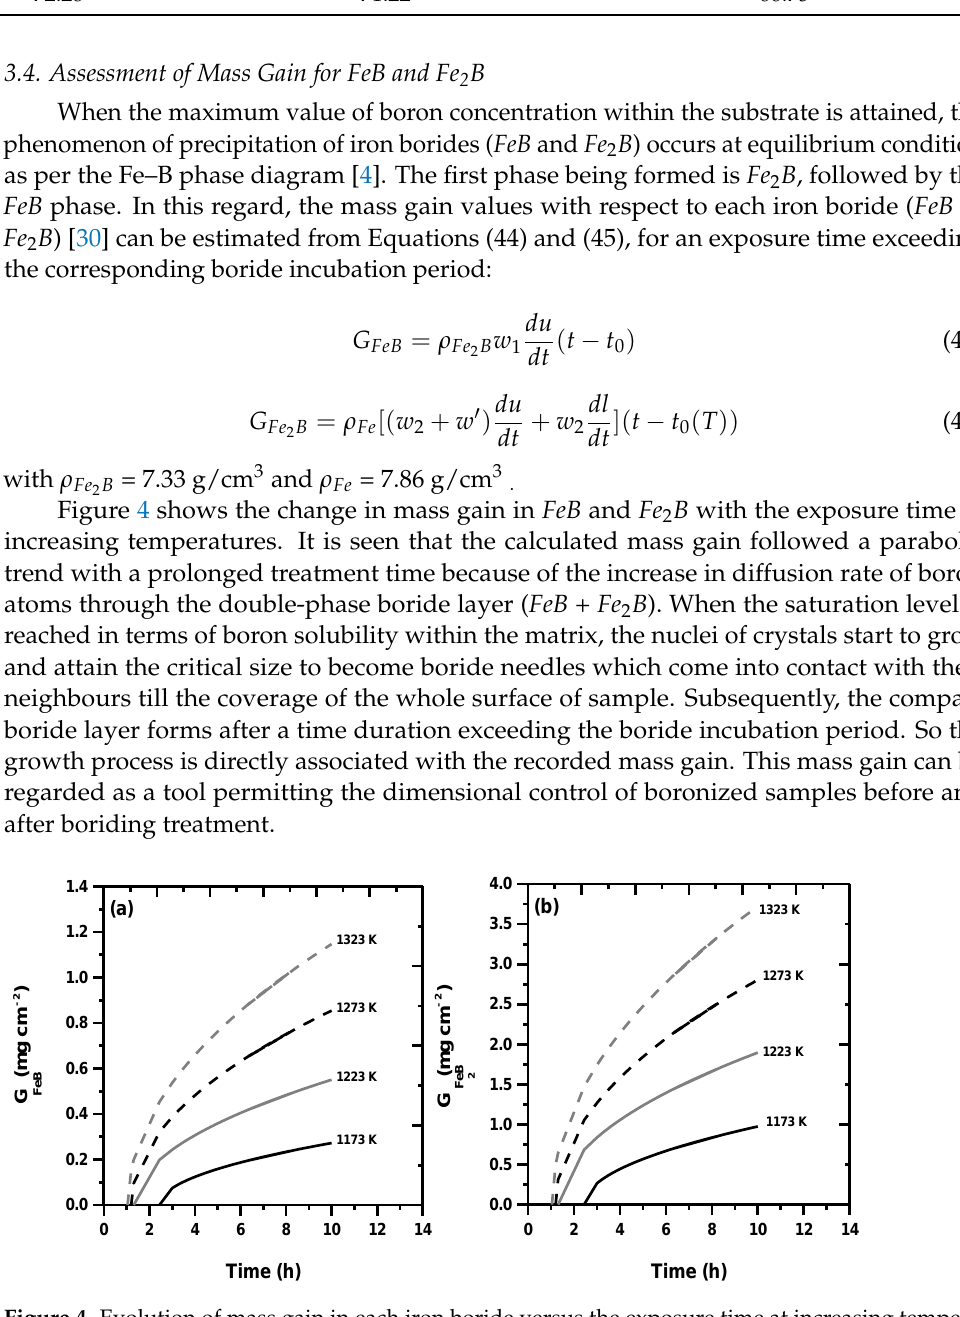
Figure 4. Evolution of mass gain in each iron boride versus the exposure time at increasing temperatures ( a ): FeB and ( b ): Fe 2 B .